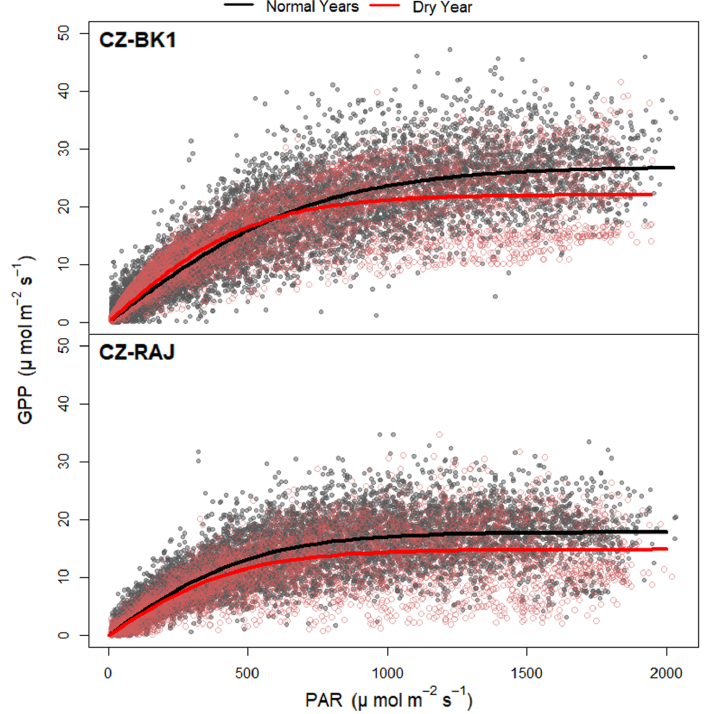
Figure 2. Response of gross primary productions to photosynthetically active radiation during the years with normal conditions (black) and affected by drought stress (red) in CZ-BK1 and CZ-RAJ. The half-hourly GPP values (points) were fitted using the logistic sigmoid light response curves